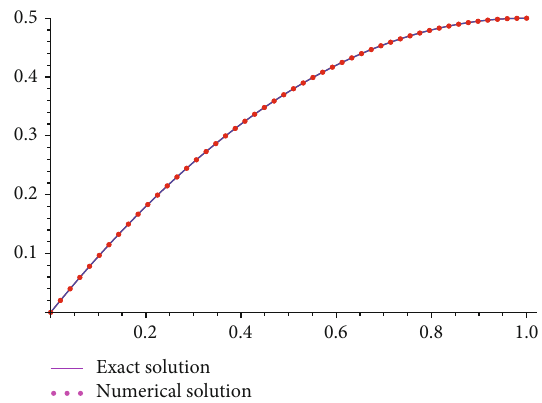
Figure 20: Comparisons between numerical and exact solutions of u 2 obtained by the present method for Example 3.